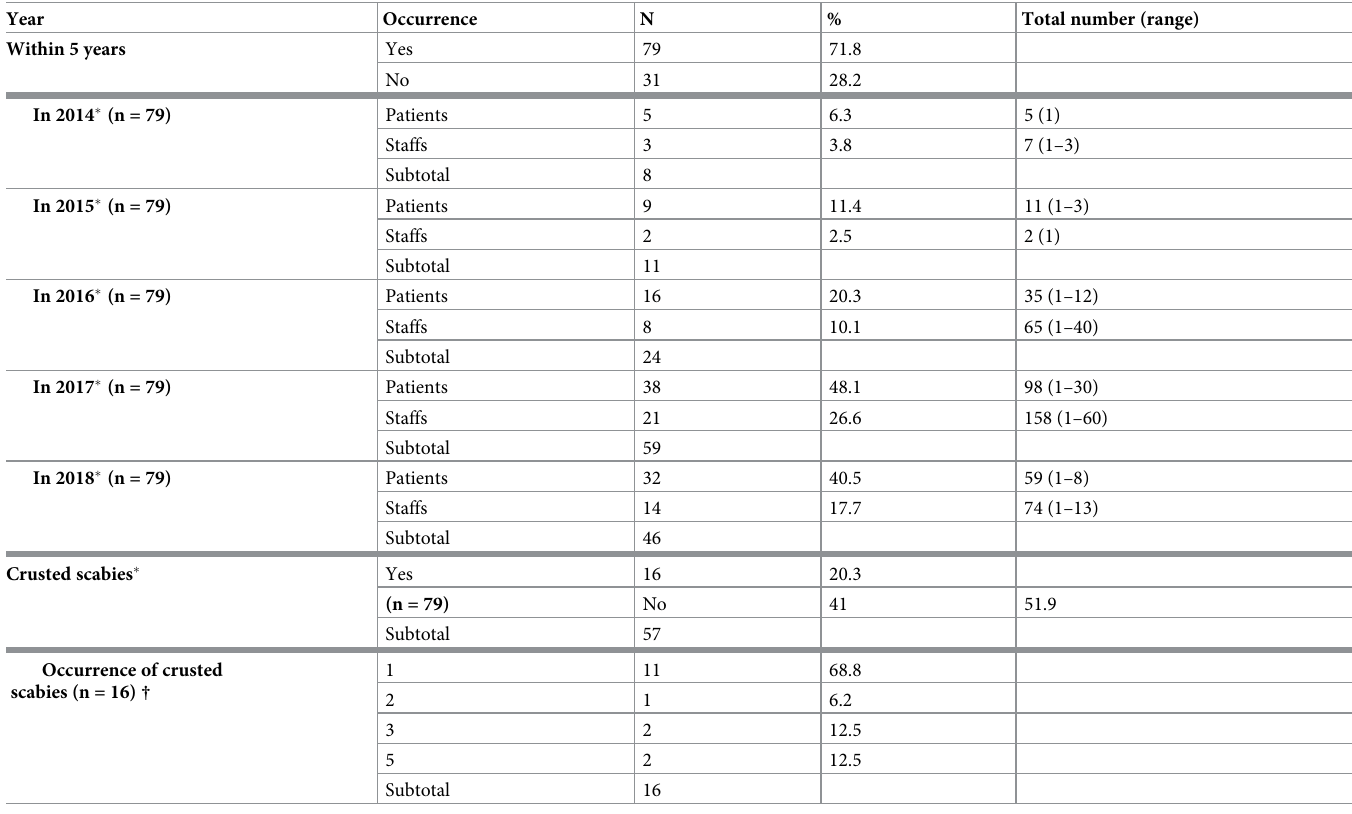
Table 2. Prevalence of scabies (N =